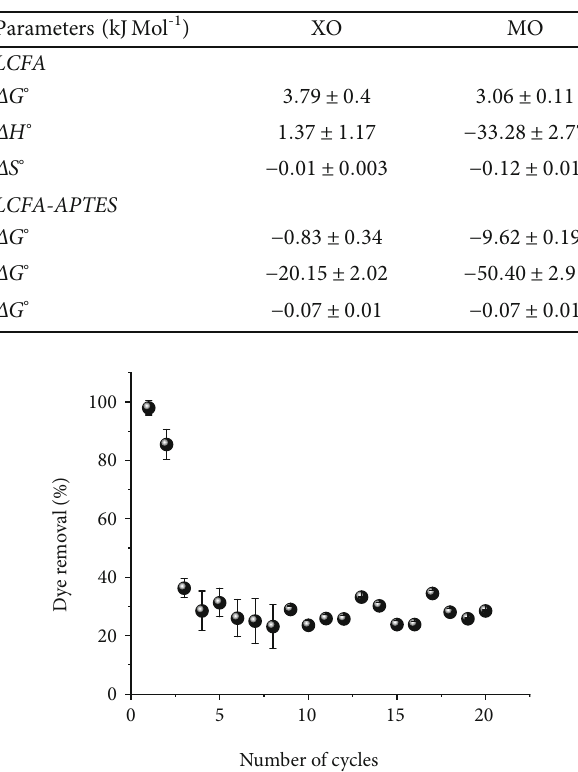
and XO on LCFA and LCFA-APTES.